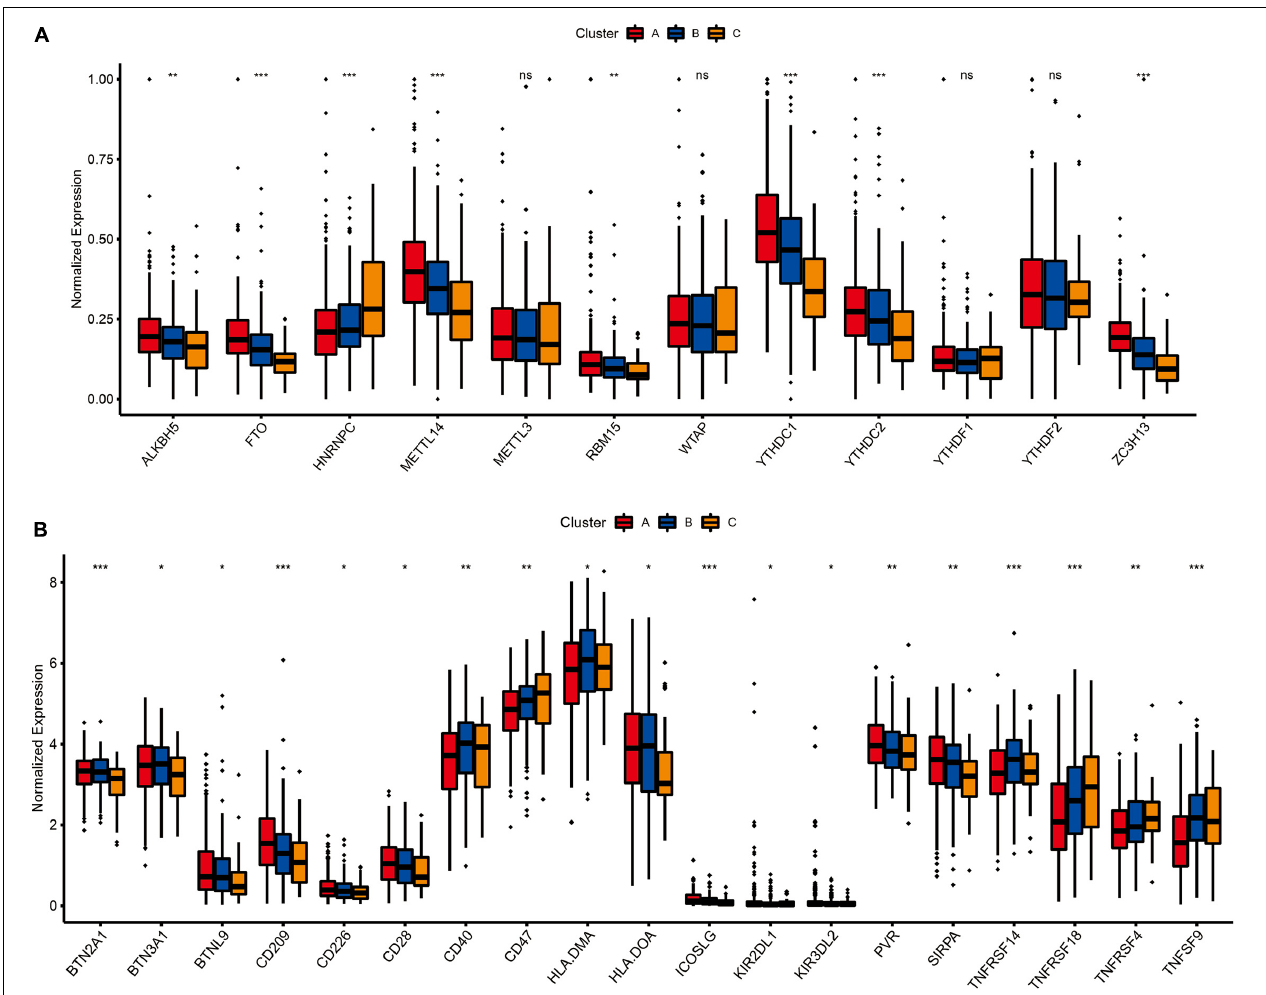
FIGURE 6 | The relationship between LUAD subtypes and m 6 A regulators and immune checkpoints. (A) Differences in expression of m 6 A regulators among three pyroptosis-related molecular subtypes. (B) Differences in expression of immune checkpoint blockade genes among three pyroptosis-related molecular subtypes. Adjusted P -values were showed as: ns, not significant; * P < 0.05; ** P < 0.01; *** P < 0.001.